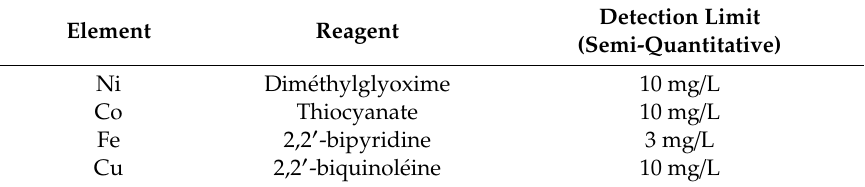
Figure 14. Black ceramic watch band (D2.2). SEM analysis of microfibers from filter paper. Screening tests of elements Ni, Co, Cu and Fe were carried out. The detection limits for Merckoquant ® type strips are shown in Table 10. Table 10. Reagents and detection limit (Merck TM ).